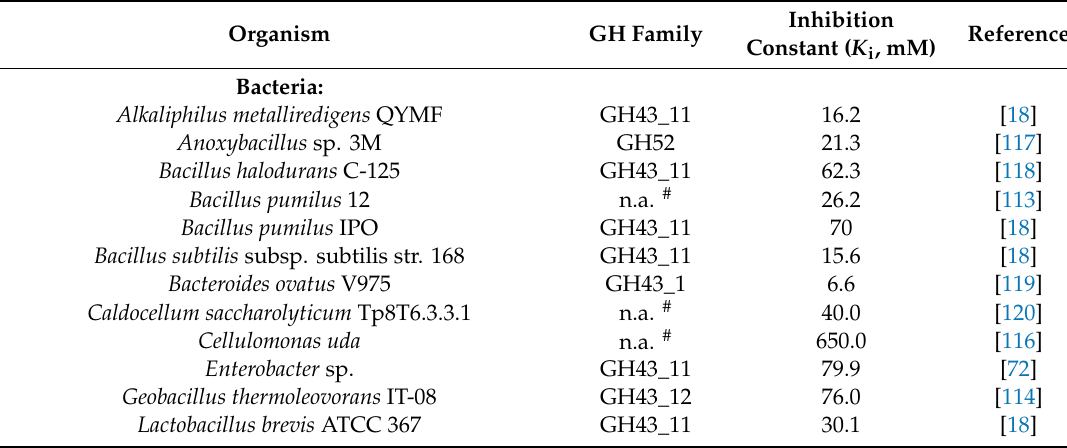
Table 3. Examples of inhibition constants for d -xylose of β